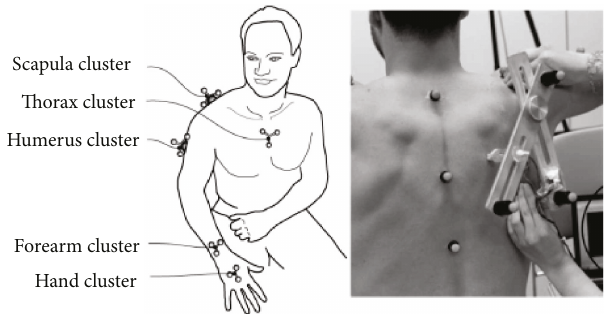
Figure 5: Placement of clusters of Optotrak